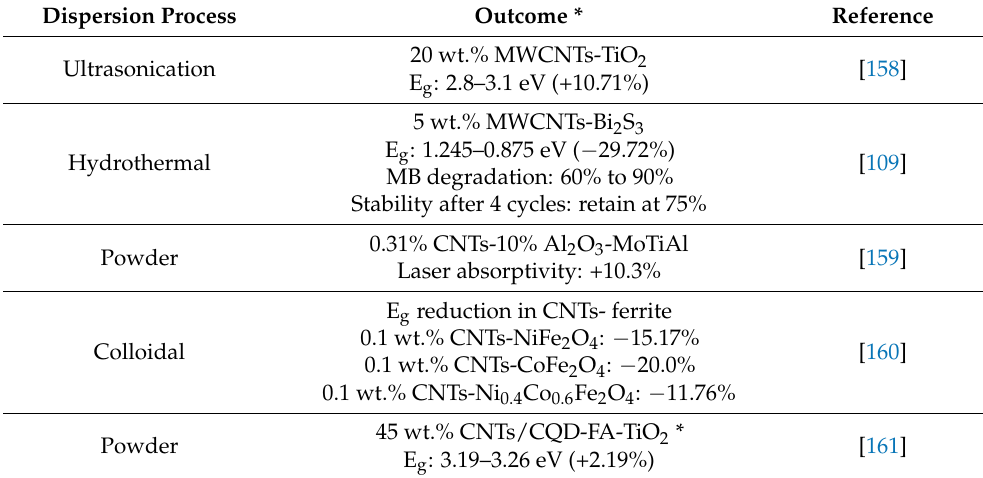
Figure 17. Schematic diagram of band structure in a material predominant with indirect bandgaps and other electronic transitions. DF: direct forbidden transition, DA: direct allowed transition, IA: indirect allowed transition, and IF: indirect forbidden transition. Table 10. The enhanced optical properties in CNTs-CMCs from previous studies in the literature.